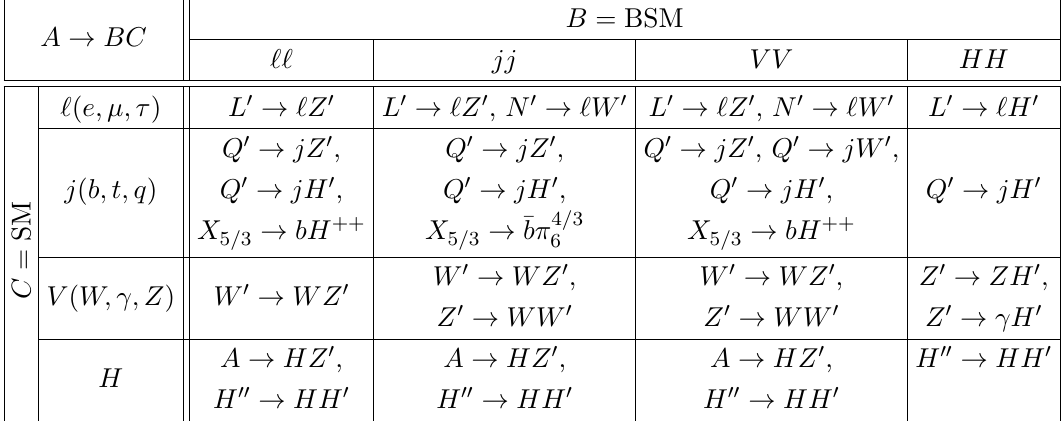
Example theoretical models for two-body decay of a BSM particle A into a BSM particle B and an SM particle C , where the B particle subsequently decays to two similar SM particles (Group II in table 1). The jj denotes B decays to q (cid:22) q / q (cid:22) q 0 / qq , and the V V includes the B decays to gg , (cid:13)(cid:13) , (cid:13)Z , ZZ , WW , or ZW . The H is the observed Higgs boson, H 00 and H 0 are heavy scalars, A is a new pseudo scalar, and H ++ denotes a doubly-charged scalar particle. The Q 0 represents a generic vector-like quark. In particular, an exotic vector-like quark with electric charge 5 = 3 is denoted as X . The (cid:25) 4 = 3 is a color-sextet scalar with electric charge 4 = 5 = 3 6